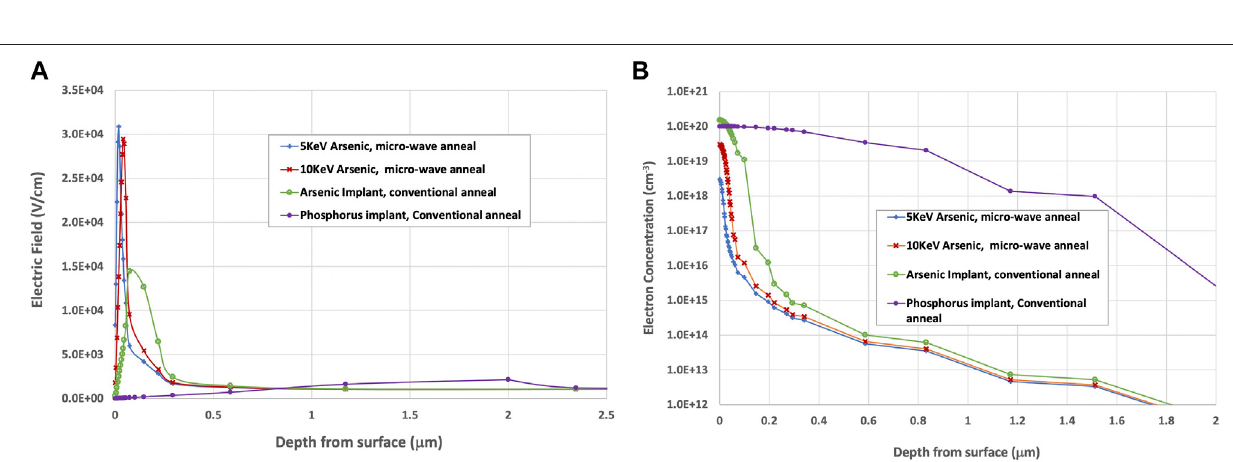
FIGURE 9 | With simulated applied bias of 100 V (A) Electric fi eld near entrance window, and (B) electron density near entrance window. These results are the same for the center and corner contact versions of the simulation.